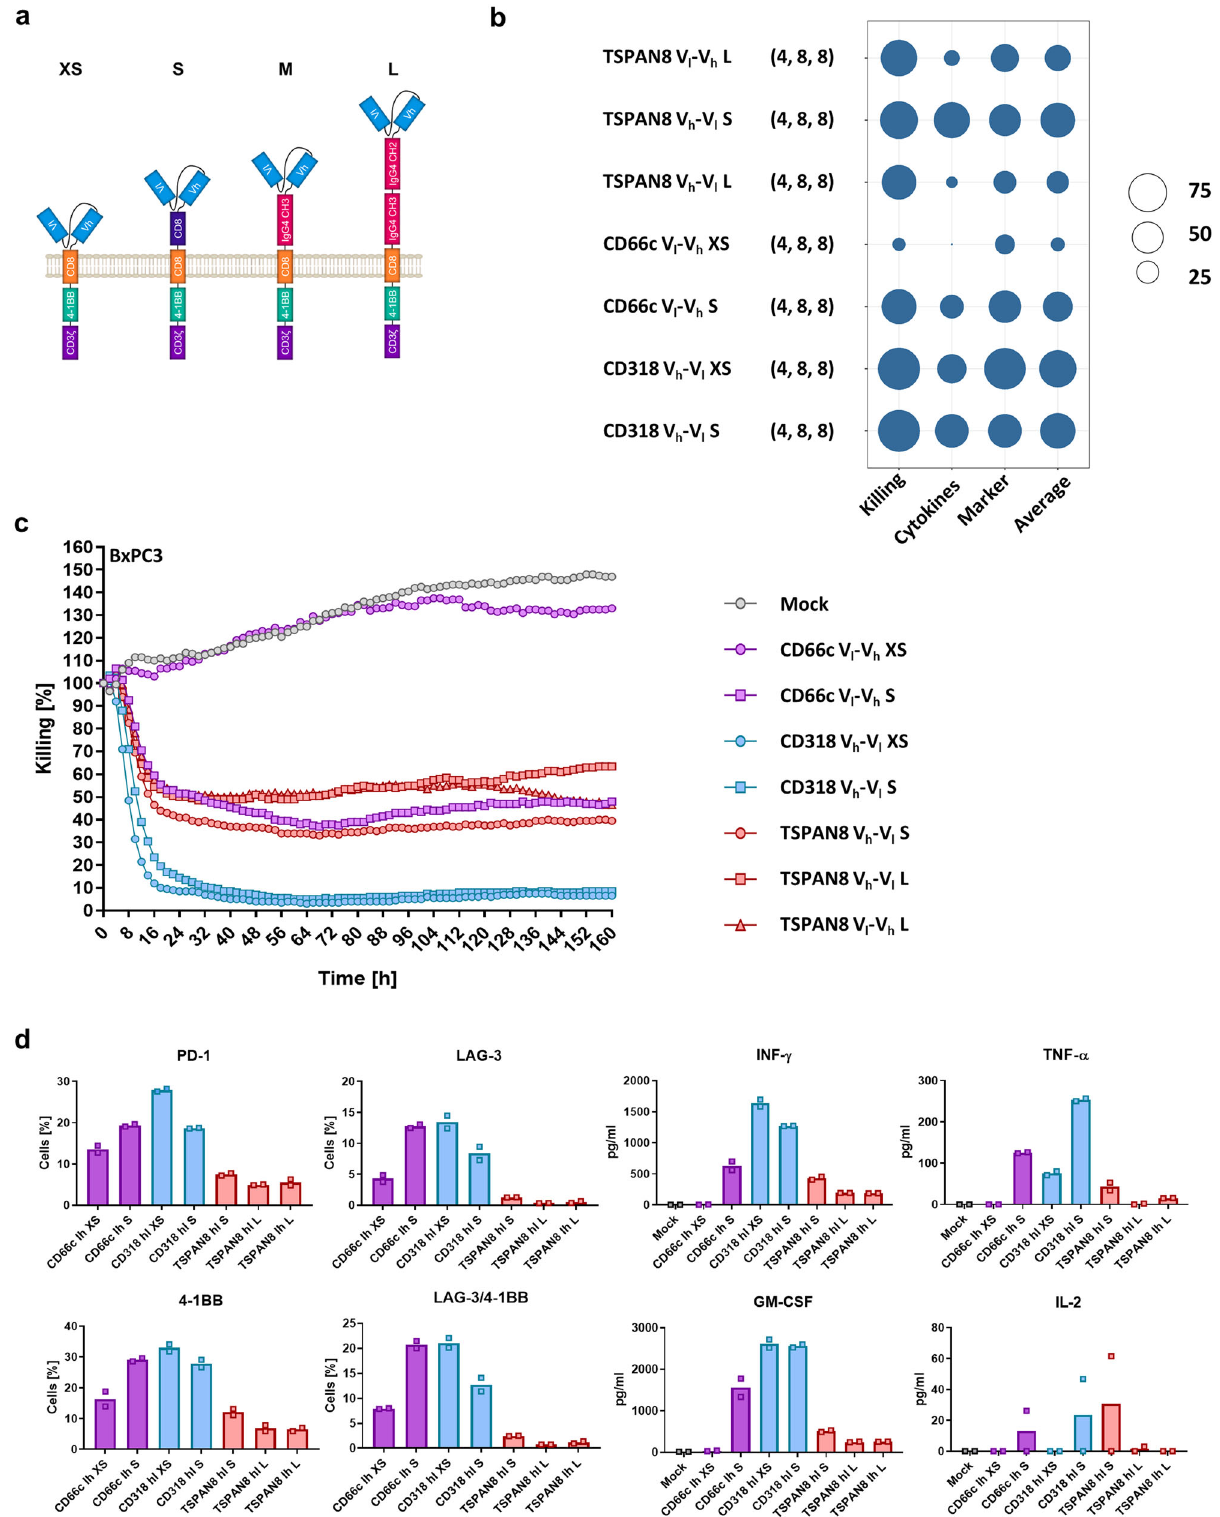
after 6 days (Fig. 4b – d). We could verify that this drop in BLI signal and increase in size was accompanied by tumor cell lysis correlated with massive CAR T cell and macrophage in fi ltration (Fig. 5c). Complete and fast tumor eradication was observed in the CD318 XS CAR-treated group. The TSPAN8 S CAR showed a slower therapeutic kinetic, but achieved tumor clearance in